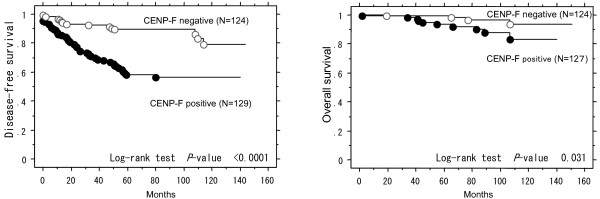
Kaplan-Meier curves of disease-free survival in 253 patients and overall survival in 251 patients with primary breast cancer as having low or high rates of CENP-F positive cancer cells. A cut-off point of 10% positive nuclei was used. The P value was calculated using the log-rank test.